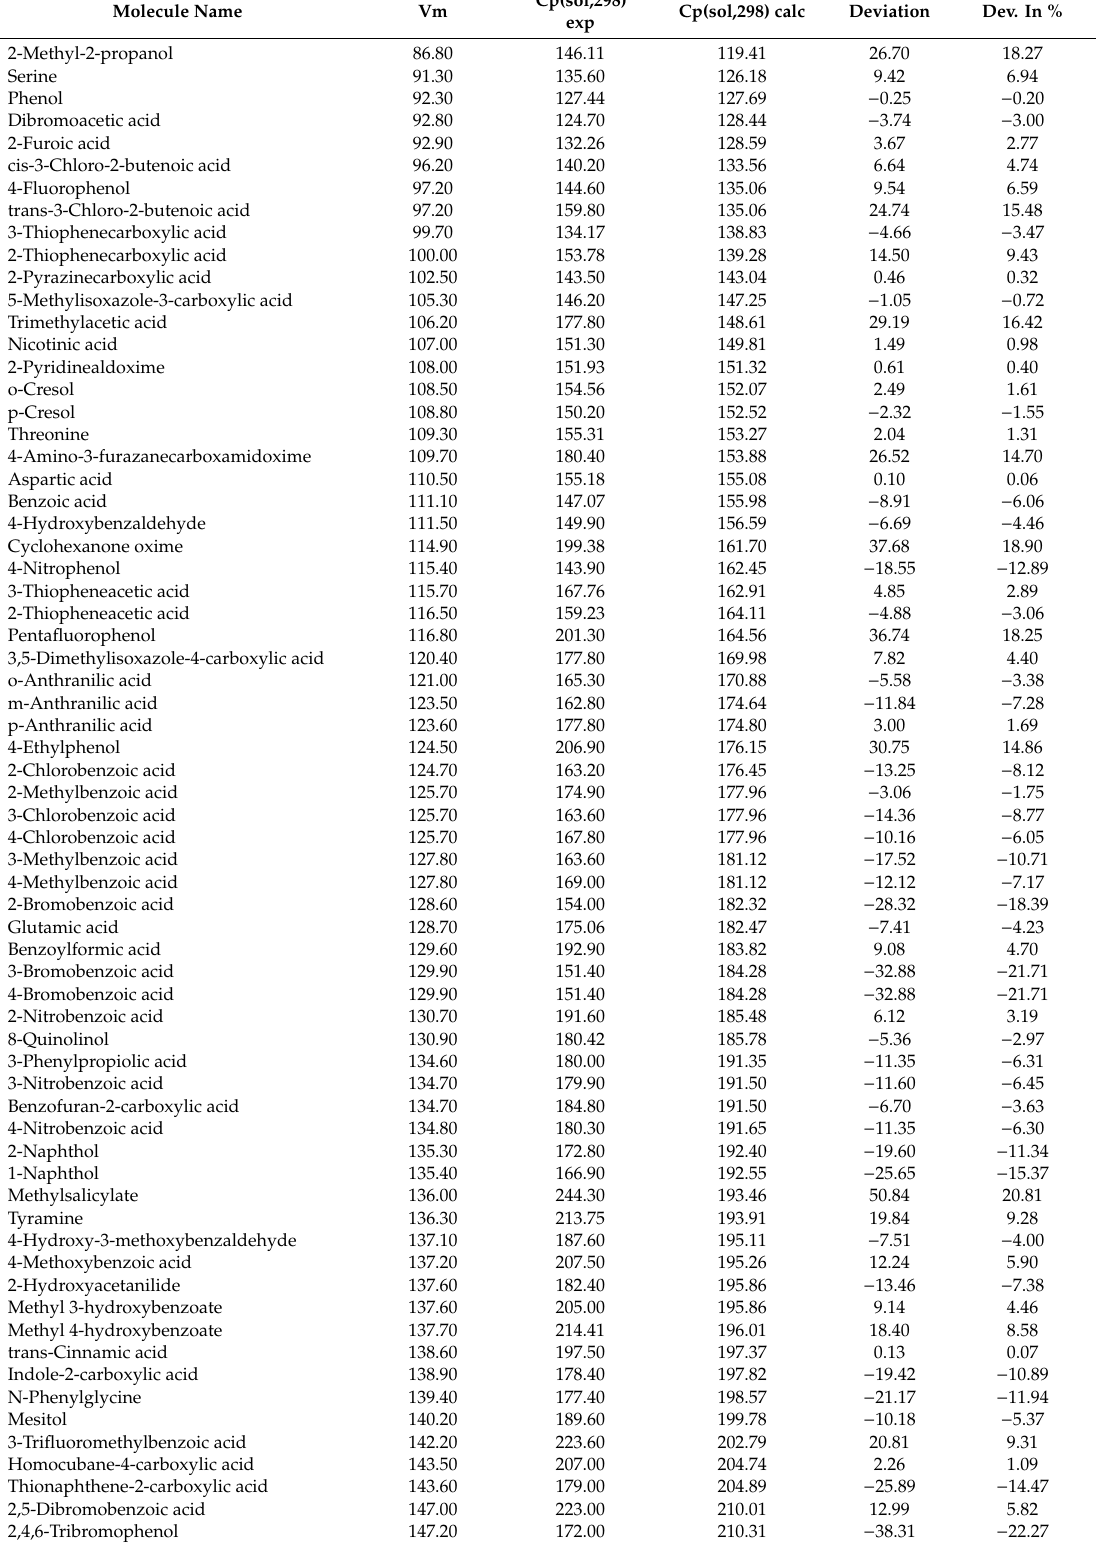
Table 9. Molecular volumes, experimental and calculated Cp(sol.298) of 123 monools and monoacids in J / mol /